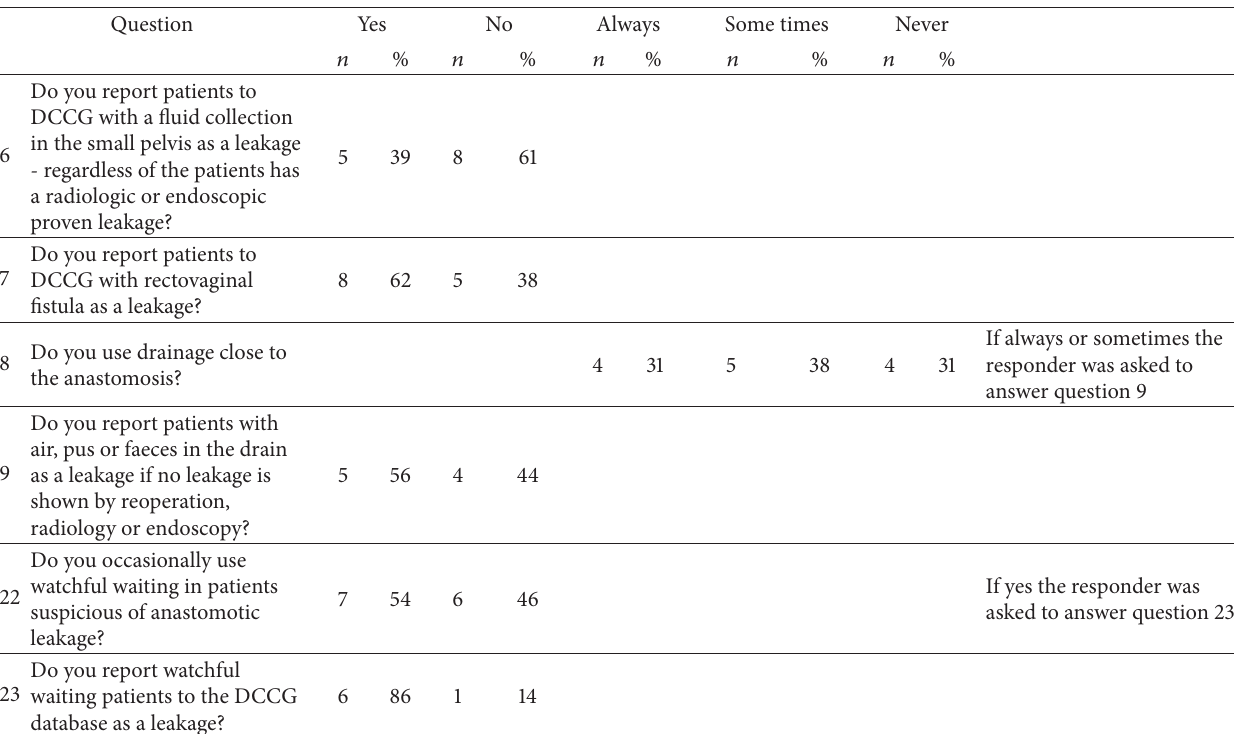
Table 1: Core question about fluid collection, rectovaginal fistula, drainage, and watchful